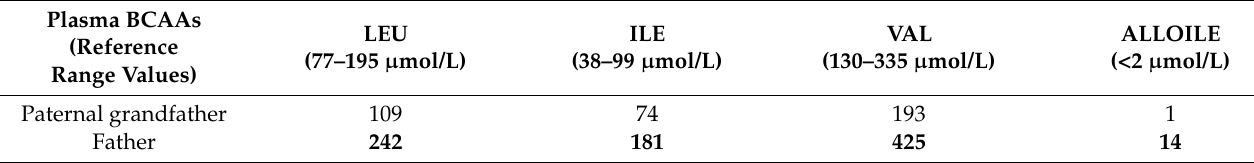
Table 3. Plasma BCAAs and alloIsoleucine after protein load